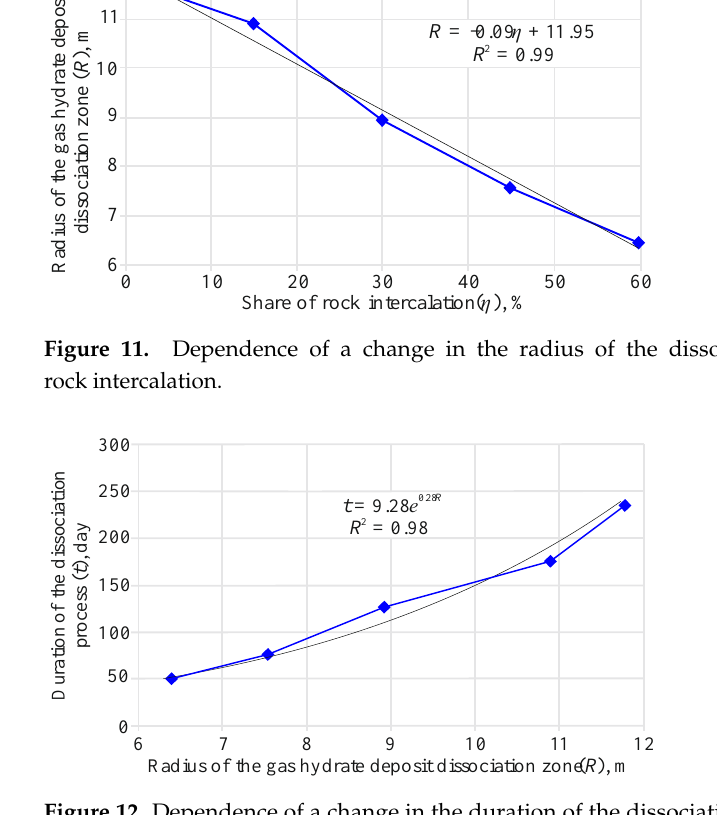
Figure 12. Dependence of a change in the duration of the dissociation process on the dissociation zone radius of the gas hydrate deposit.